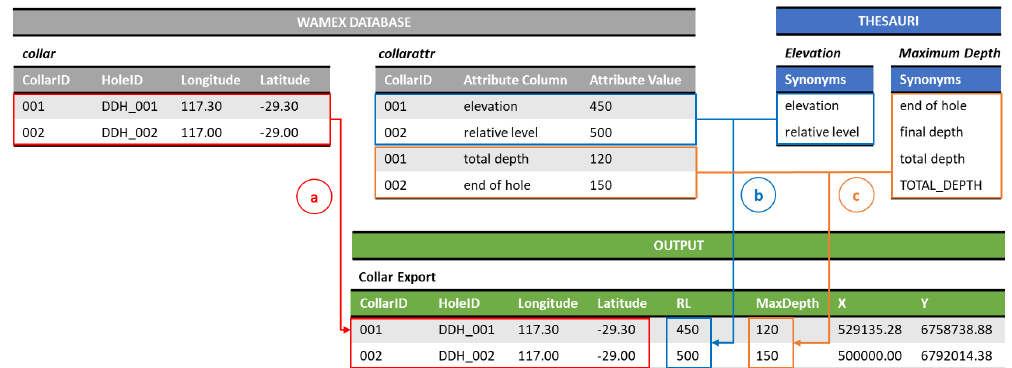
Figure B3. Collar extraction workflow.